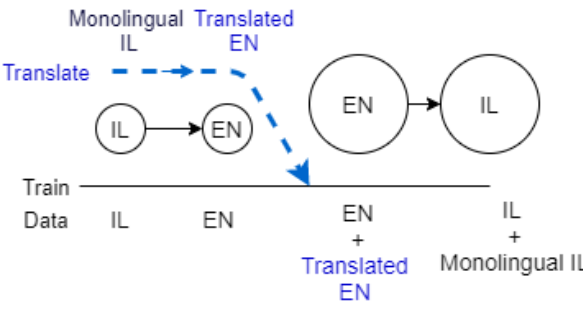
Figure 1. Experimental